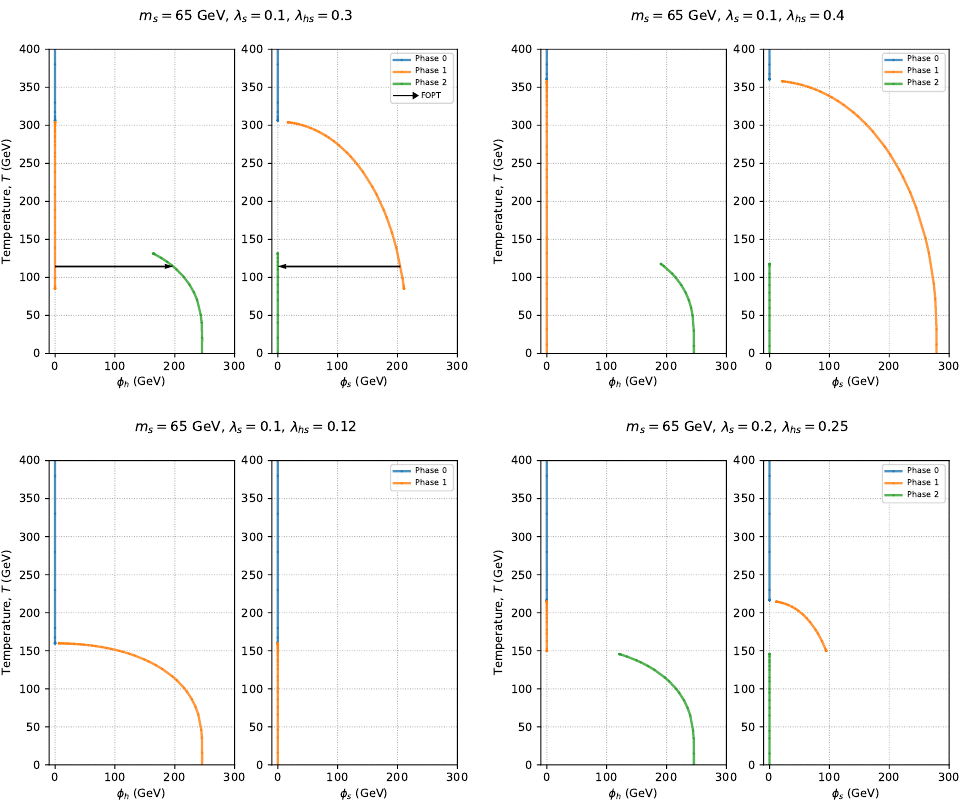
Figure 16 . Typical phase structures in the SSM. The lines show the field values at a particular minimum as a function of temperature. The arrows indicate that at that temperature the two phases linked by the arrows are degenerate and thus that a FOPT could occur in the direction of the